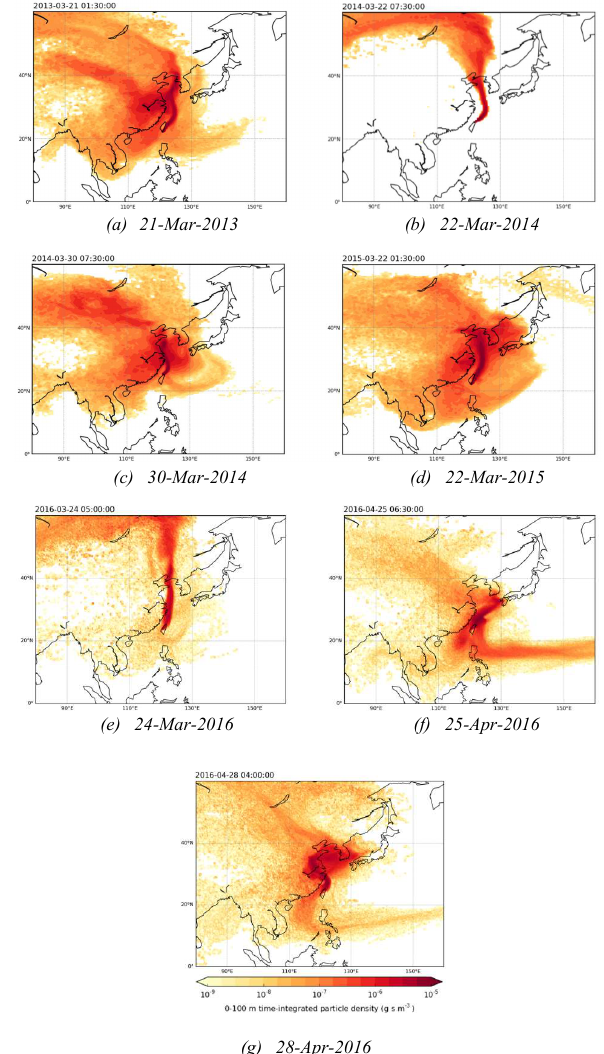
Figure 7. NAME footprints derived from 12-day backward simu- lations and showing the time-integrated density of particles below 100m altitude for the approximate times when samples were col- lected during the Taiwan campaign. (a) , (c) , (d) and (g) are exam- ples of one enhanced CFC-113a mixing ratio in each year. (f) is the sample taken just before (g) when the air was coming from a dif- ferent direction and the mixing ratio of CFC-113a was much lower. (b) and (e) are also examples of samples with lower CFC-113a mix- ing ratios. Arrows in Fig. 8 show the mixing ratios of CFC-113a for these NAME footprints. For the rest of the NAME footprints see the Supplement.